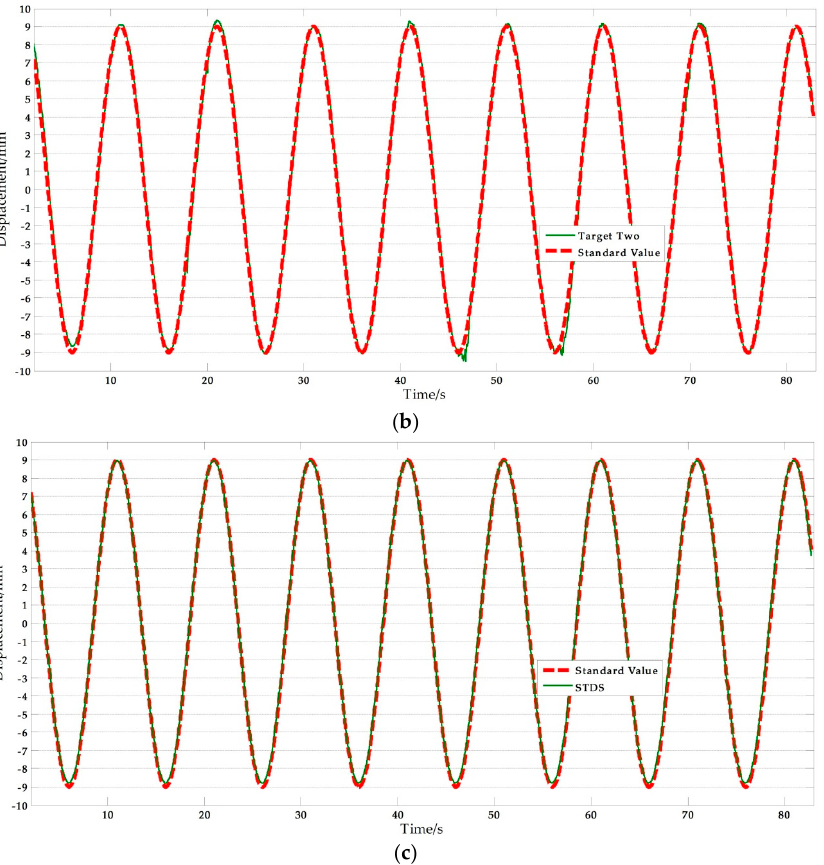
Figure 13. Free target measurement comparisons: ( a ) Measurement results of vision sensor capturing target one compared with standard values; ( b ) Measurement results of vision sensor capturing target two compared with standard values; ( c ) Measurement results of STDS compared with standard values. ( f = 0.1 Hz, A = 9 mm). Table 10. NRMSE analysis of free target experimental results.